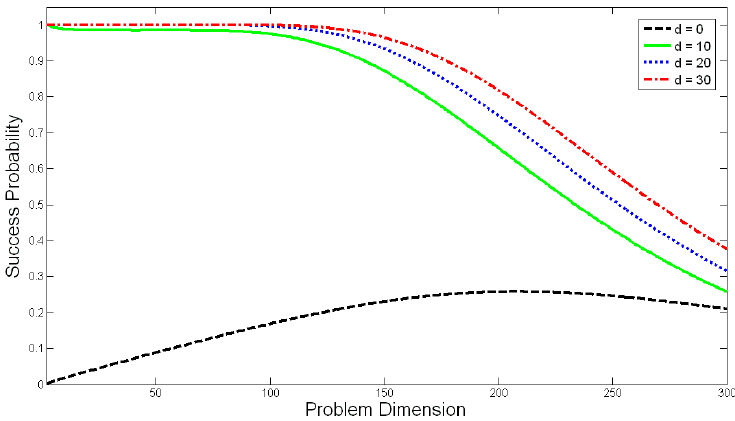
Figure5. Figure 5. Success probability of hybrid algorithm versus problem dimension in various local search sizes.